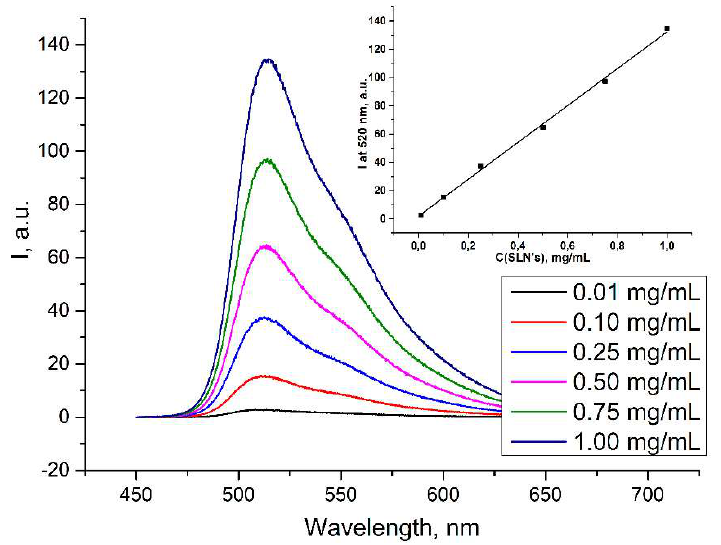
Figure 2. Emission spectra of SLNs (0.01–1 mg/mL) and emission intensity at 520 nm vs. SLN concentration (insert).